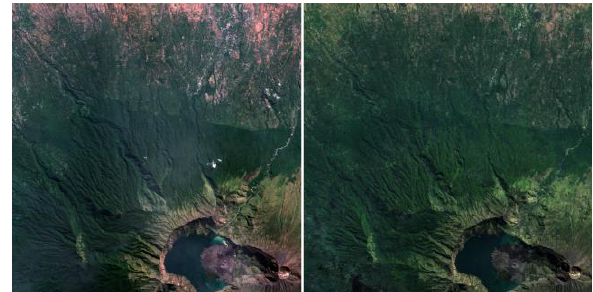
Figure 11. Squared sample of 20 km along the Pre-disaster image scene. (Left) Original image taken at July 02, 2018; (Right) Cloudless image obtained by means of the M2CTool The performance of the M2CTool has been assessed first by analyzing scatterplots of reflectance values. In particular, the reconstructed cloudless image has been compared (band-by- band) with an uncontaminated squared sample of the Sentinel-2 image. Scatterplots for the four bands are given in Figure 12.